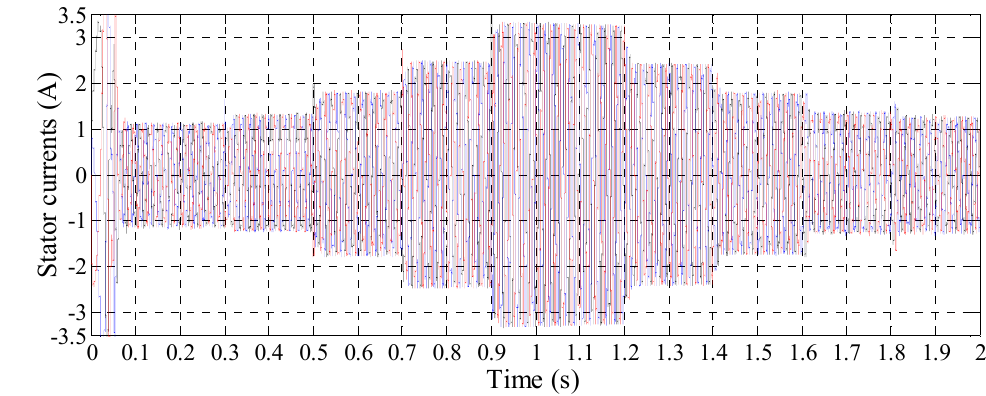
Figure 20. Full speed response with mechanical load variations. Figure 20 . Full speed response with mechanical load variations. Figure 20 . Full speed response with mechanical load variations.